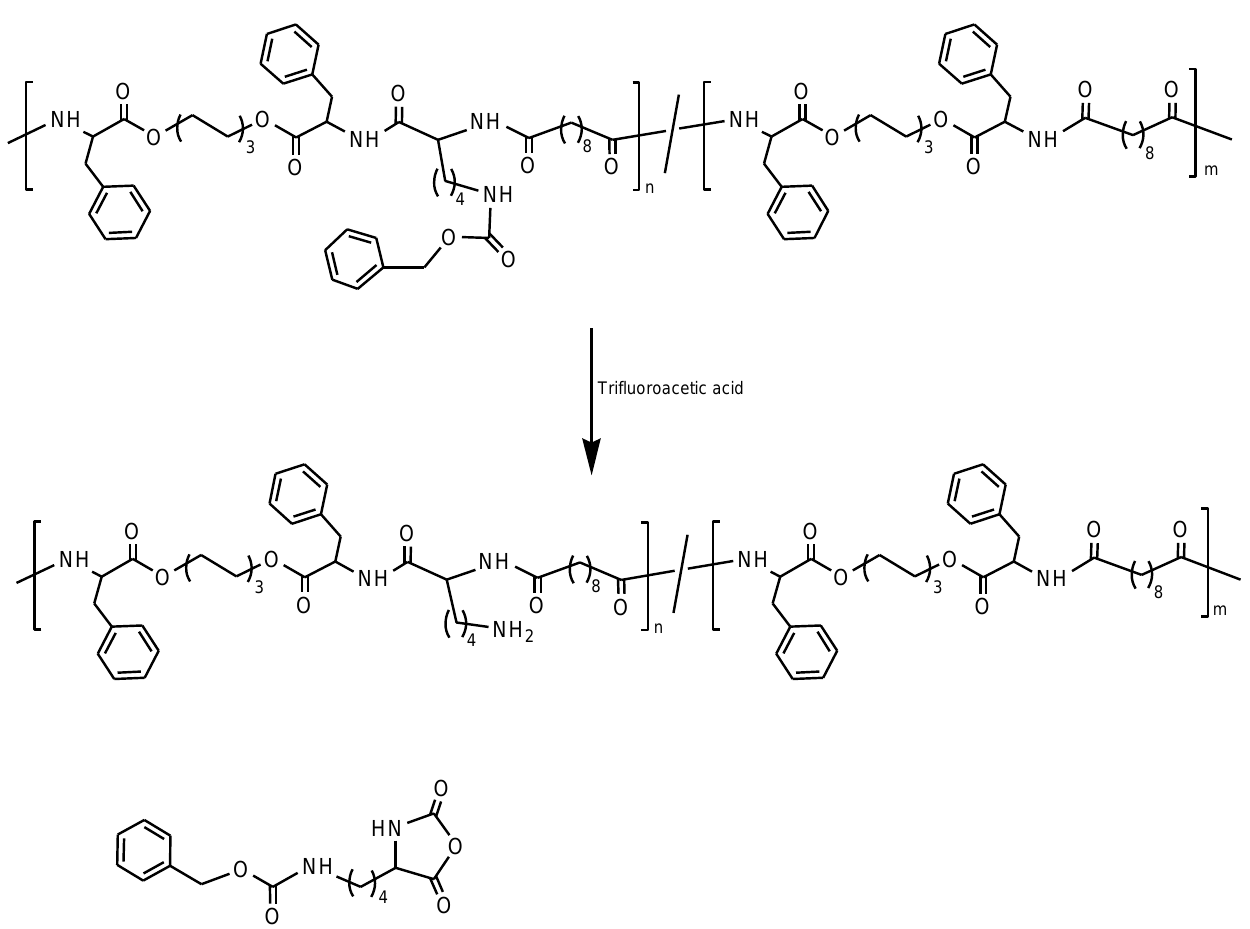
Figure 12. Random poly(ester amide)s with functional amine groups from N  -  benzyloxycarbonyl)-L-lysine N -carboxyanhydride derivatives.